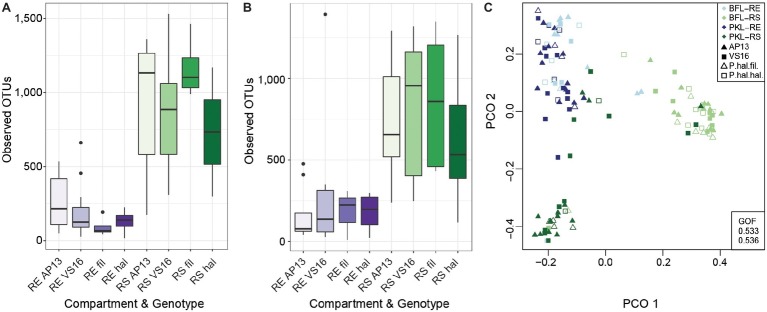
Alpha Diversity of root and soil microbiomes at PKL (A) and at BFL (B) and Principal Coordinate Analysis of RS and RE samples from both sites (C). Colors denote plant compartment, shapes in PCO plot show ecotype. Panicum species and compartments are abbreviated as follows: P. hal. var. fil. ~ filipes, P. hal. hal. ~ hallii, P. virgatum AP13 ~ AP13, P. virgatum VS16 ~ VS16; Rhizosphere ~ RS, Root Endosphere ~ RE. GOF = Goodness of fit.